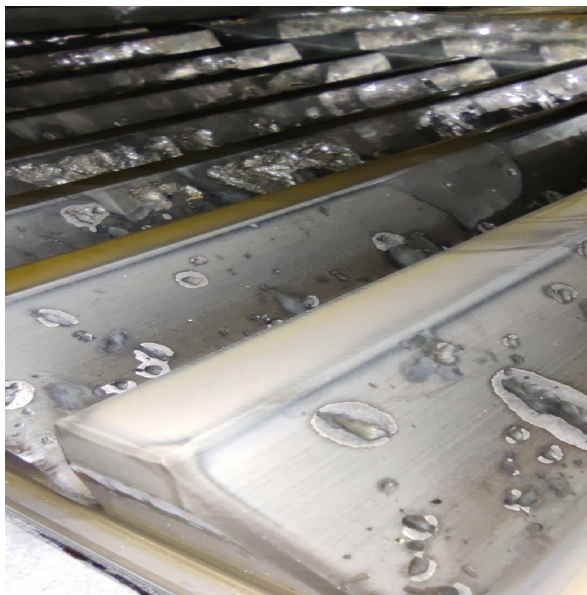
Figure 5. Damage to planetary gear toothed wheels.